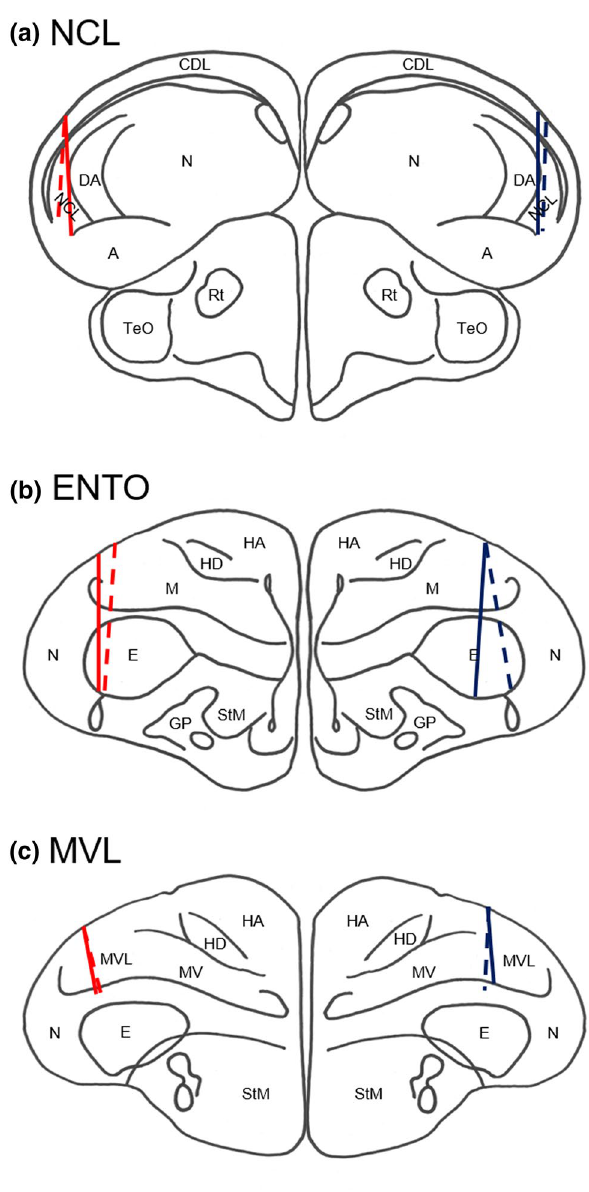
Figure 2. The electrode track reconstruction. ( a ) NCL. Solid red line—C3; dashed red line—B2; solid blue line—B9; dashed blue line—C8. ( b ) ENTO. Solid red line—C4; dashed red line—B10; solid blue line—B11; dashed blue line—B5. ( c ) MVL. Solid red line—D12; dashed red line—D10; solid blue line—D14; dashed blue line—D11. Brain regions (as defined by Reiner et al. 53 ): A, arcopallium; CDL, area corticoidea dorsolateralis; DA, tractus dorso-arcopallialis; E, entopallium; HA, hyperpallium apicale; HD, hyperpallium densocellulare; GP, globus pallidus; M, mesopallium; MV, mesopallium ventrale; MVL, mesopallium ventrolaterale; N, nidopallium; NCL, nidopallium caudolaterale; Rt, nucleus rotundus; StM, striatum mediale; TeO, tectum